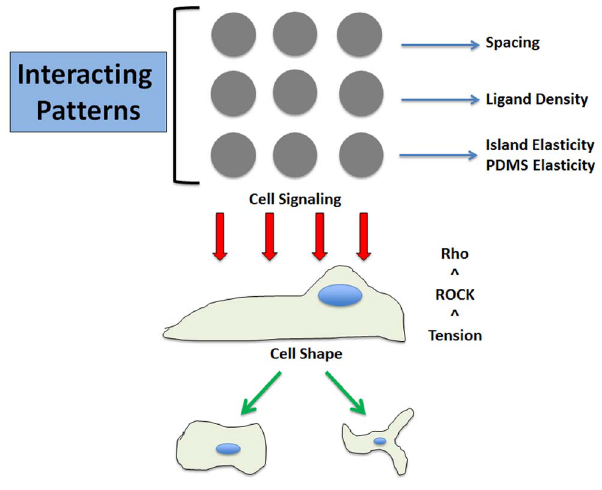
Figure 6. Schematic of mechanical decision made in hMSC commitment. Mechanical cues coordinate to drive hMSC cell shape with RhoA signaling. Interference with cytoskeletal tension disrupts this decision showing the RhoA-ROCK pathway appears critical in adhesion properties of hMSCs.